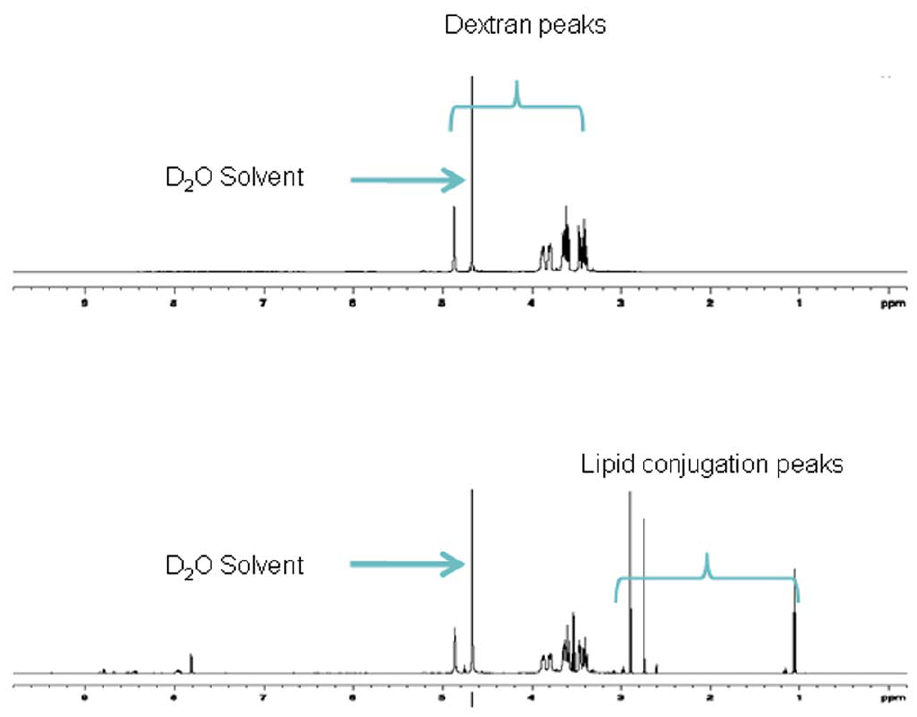
Figure 1. Characterization of stearylamine-dextran modified nanoparticles. 500 MHz 1 H NMR spectra of dextran and dextran conjugated stearyl amine after purification using D 2 O as the solvent. The spectra clearly show the additional peaks of the long chain fatty amine at , 1ppm indicating the successful lipid modification of dextran. The % fat modification was estimated to be 7 mole % of dextran.